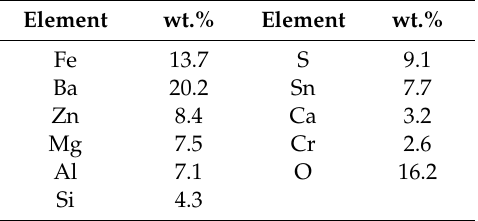
Table 2. Elemental composition of the friction material used in the study. Carbon is not quantified. Element wt.% Element